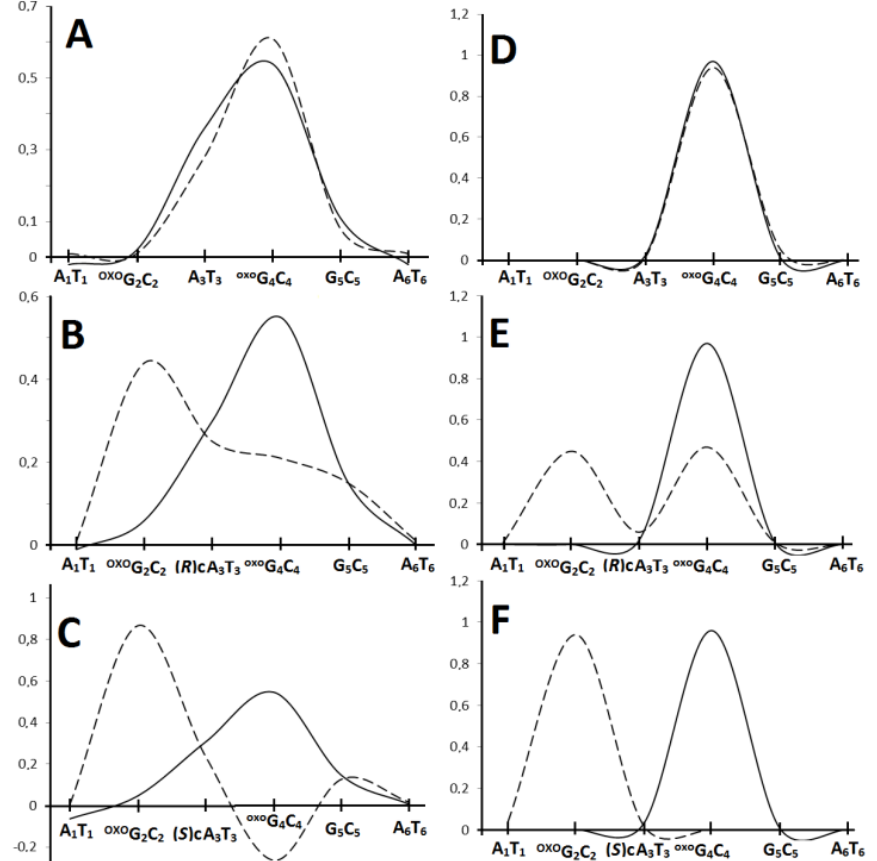
Figure 5. Vertical (---) as well as adiabatic ( ___ ) Hishfeld charge and spin density distribution in a purine strand of the investigated ds-oligonucleotides; the base pair notation has been used for clarity, ( A – C ) and ( D – F ), respectively. oxo dG 2,4 DNA ( A , D ); ScdA oxo dG 2,4 DNA ( B , E ); RcdA oxo dG 2,4 DNA ( C , F ). The whole row data is presented in Table S5.